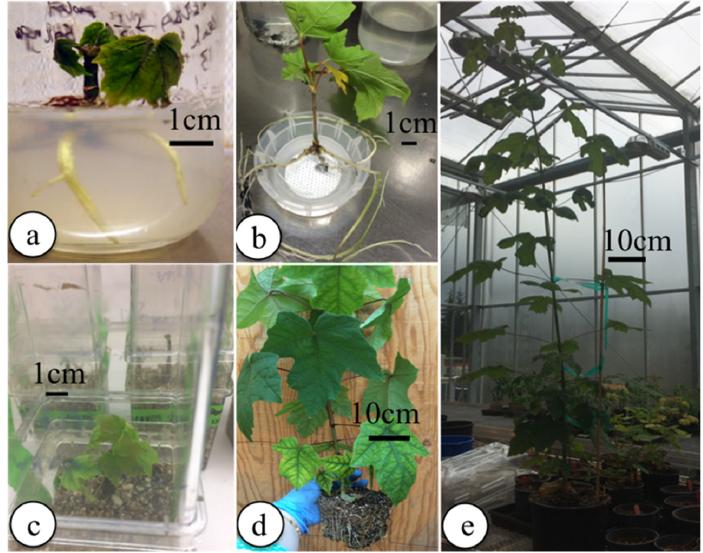
Figure 5. Rooting and acclimatization of bigleaf maple. Shoots grown for a month on medium with 0.25 μ M IBA ( a ), or 0.5 μ M IBA ( b , c ). Newly potted plant in ( c ) is shown after 1 month of acclimation